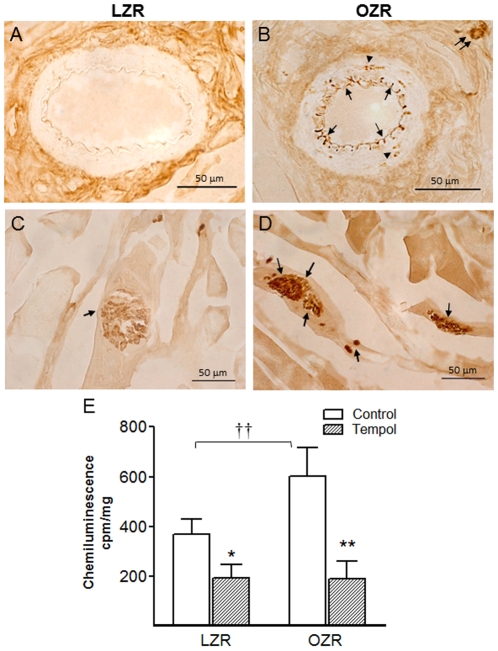
Nitrotyrosine immunostaining for peroxynitrite and superoxide production were elevated in the erectile tissue from OZR.
A–D. Nitrotyrosine immunoreaction was intense in OZR and was mainly distributed in the endothelial cell layer (arrows) lining penile arteries (B) and cavernosal spaces (D), and eventually in the arterial smooth muscle (arrow heads) and in nerve trunks (double arrows) close to the arteries (B). Nitrotyrosine immunoreaction was slight in penile arteries (A) and corpus cavernosum (C) from LZR. E. Basal superoxide production in corpus cavernosum tissue from LZR and OZR detected by lucigenin-enhanced chemiluminescence. Effect of tempol (3×10−5 M) on the basal superoxide generated expressed in counts per minute (cpm) per mg of tissue. Data are shown as the means ± SEM of 6–7 corpus cavernosum samples. *P<0.05, **P<0.01 vs control. ††P<0.01 vs LZR.